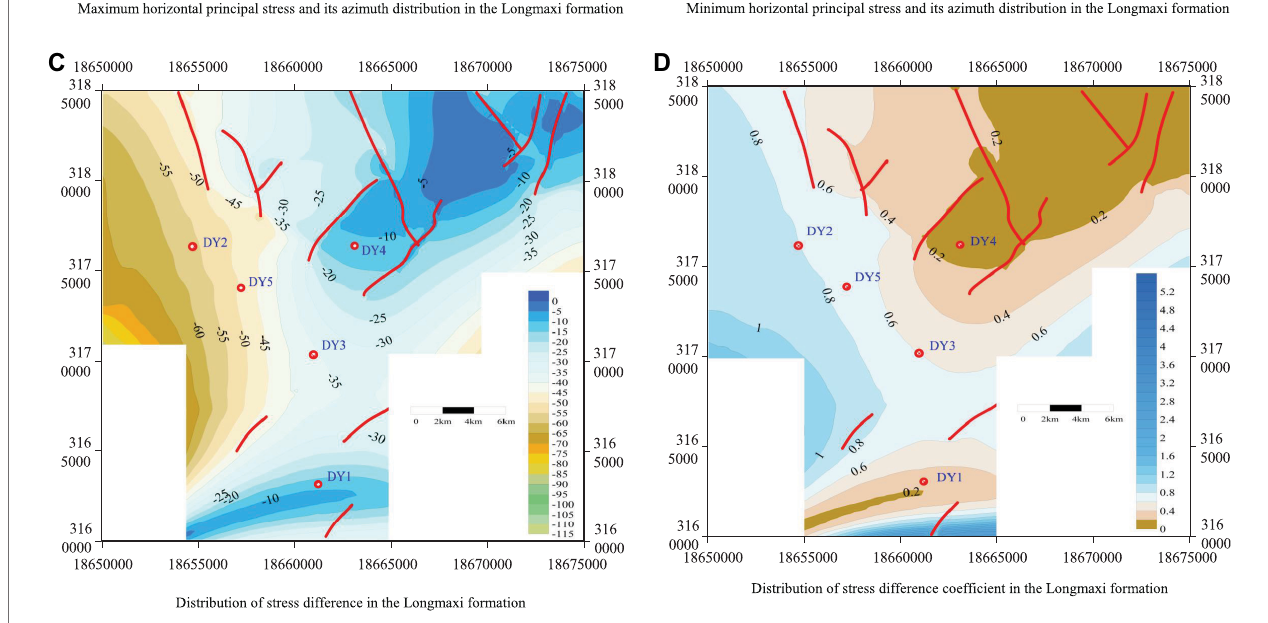
FIGURE 11 | Stress fi eld of shale gas reservoir of the Longmaxi formation in Dingshan area. (A) Maximum horizontal principal stress and its azimuth distribution in the Longmaxi formation. (B) Minimum horizontal principal stress and its azimuth distribution in the Longmaxi formation. (C) Distribution of stress difference in the Longmaxi formation. (D) Distribution of stress difference coef fi cient in the Longmaxi formation.